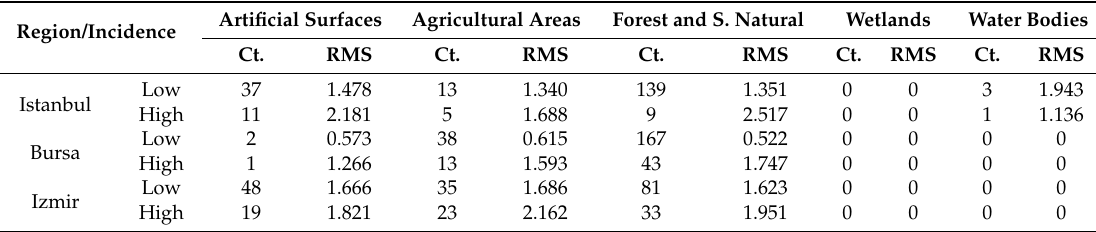
Table 4. Distribution of the number of GCPs and mean RMSEs (m) for different LC classes in the study